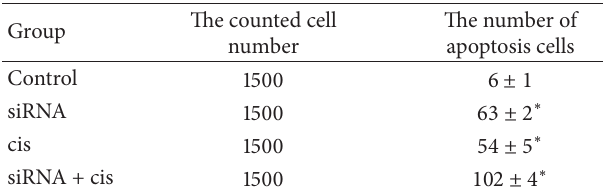
Table 4: Effects of mTOR siRNA alone or combined with cisplatin on cell apoptosis